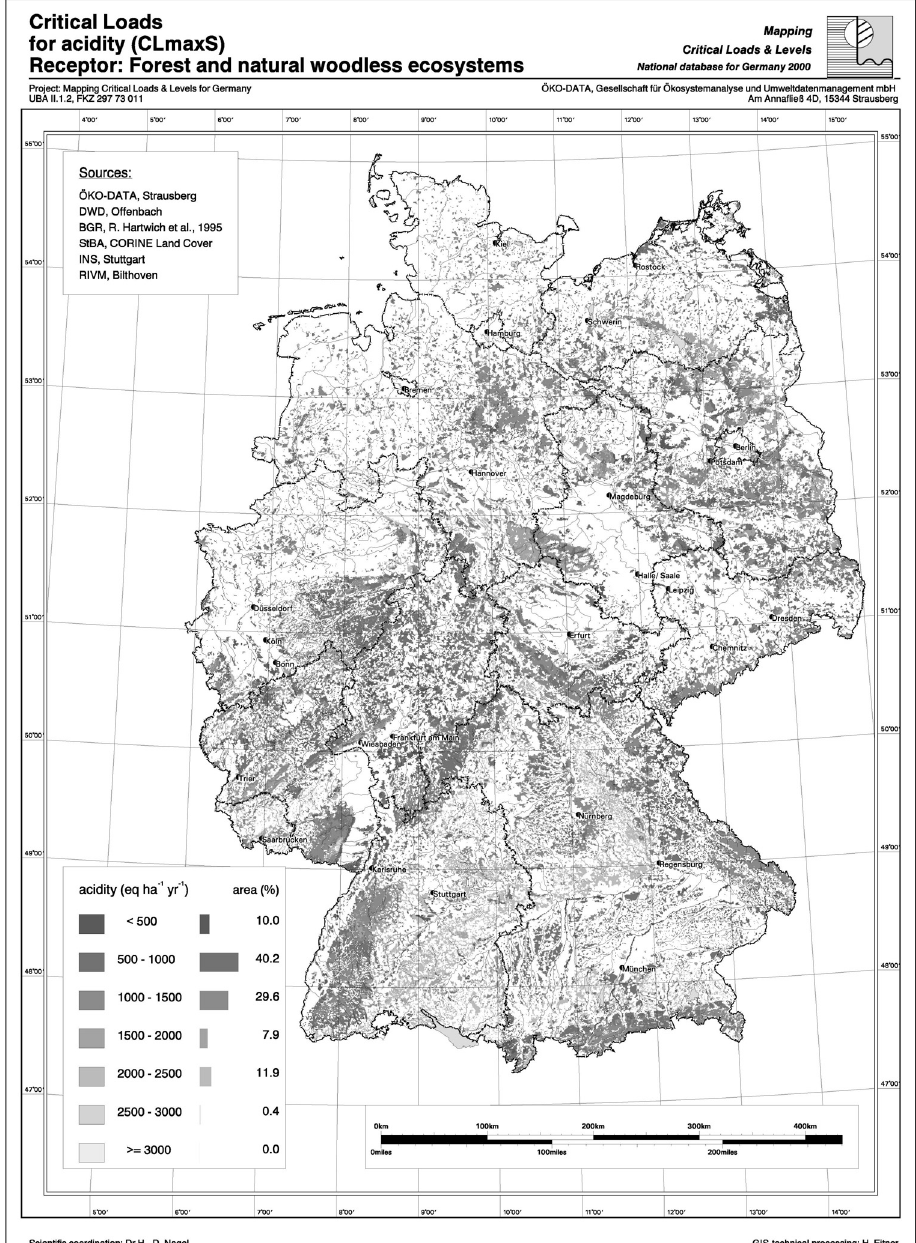
FIGURE 6 . Regional distribution of critical loads for